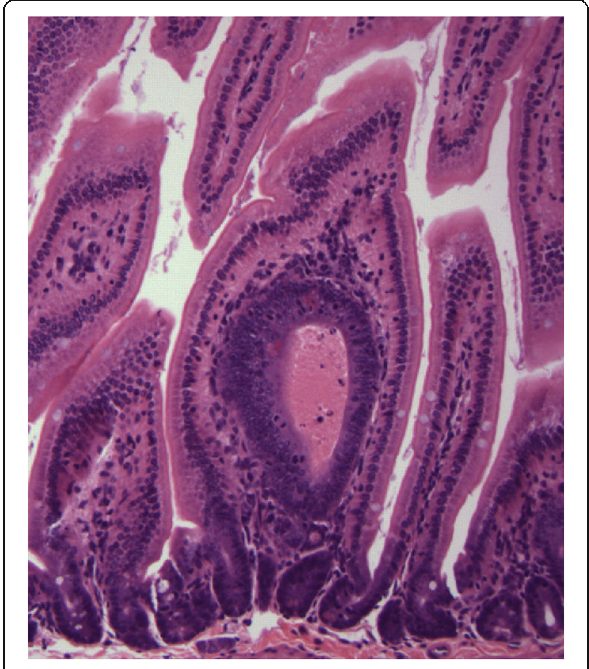
Fig. 1 A small adenoma in colonic mucosa in an Apc 1638N/+ mouse, similar to human colorectal adenomas. Note the increased nucleus- to-cytoplasm ratio and hyperchromatic, crowded pencillate nuclei